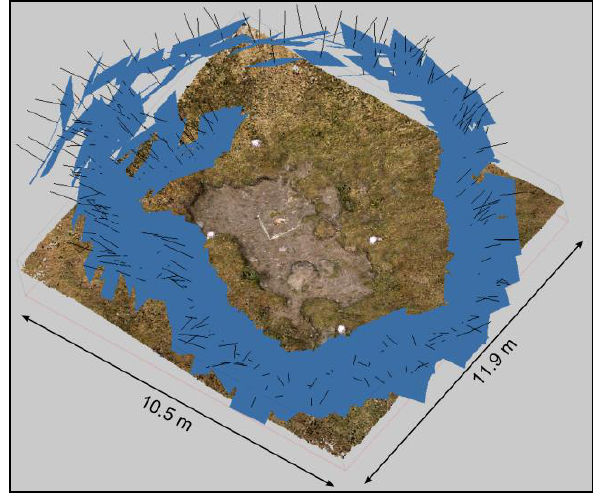
Figure 1: RGB coloured 3D point cloud of scene 10. Blue planes and black lines represent the reconstructed camera positions and